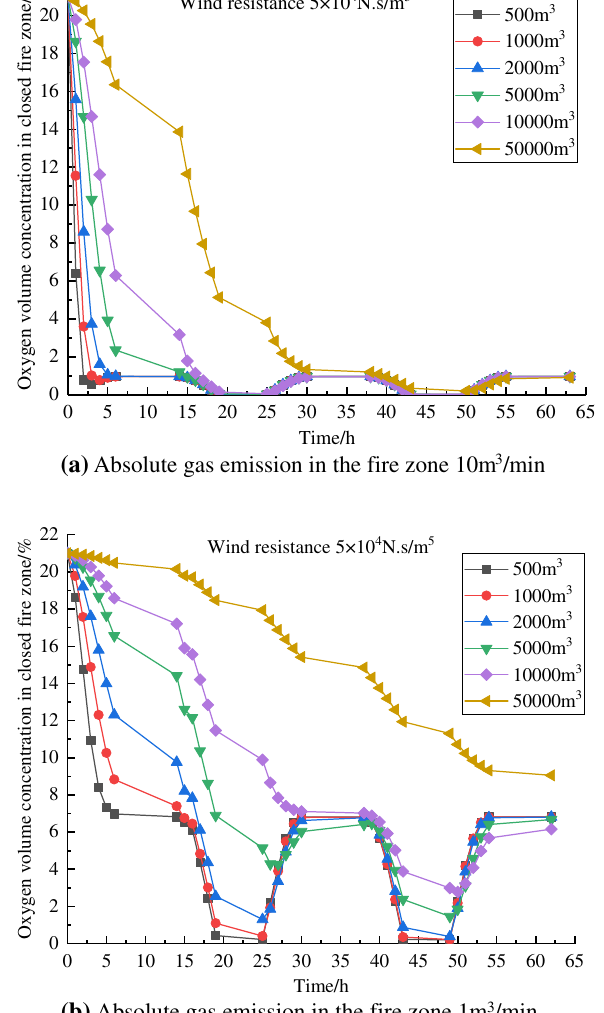
(b) Absolute gas emission in the fire zone 1m 3 /min Fig. 7 Different gas emission, different fire area volume, and large wind resistance, the relationship between oxygen concentration and time in the fire zone after the closing at 24:00 in the middle of the night